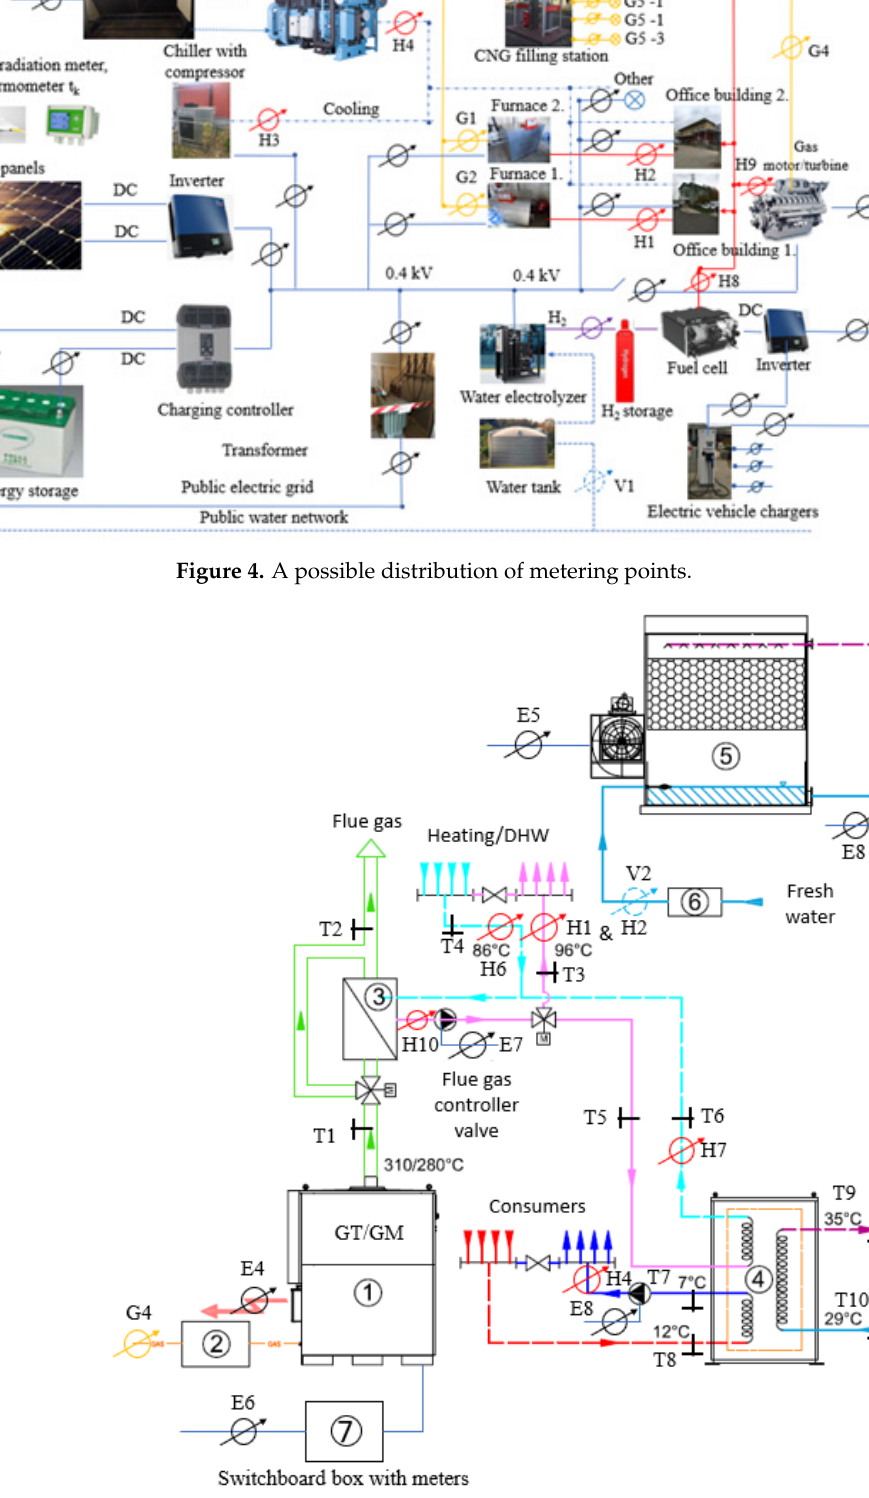
Figure 5. Suggestion for the metering places of the connected heat and electric energy producing